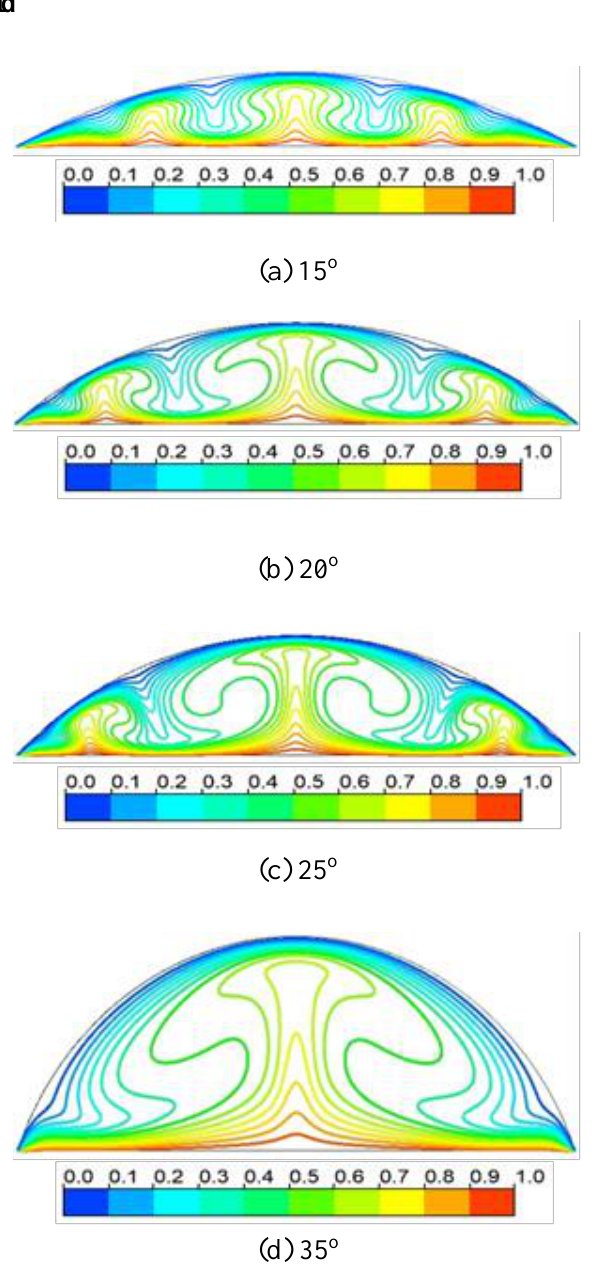
Fig. 7. Temperature field within different roof pitch